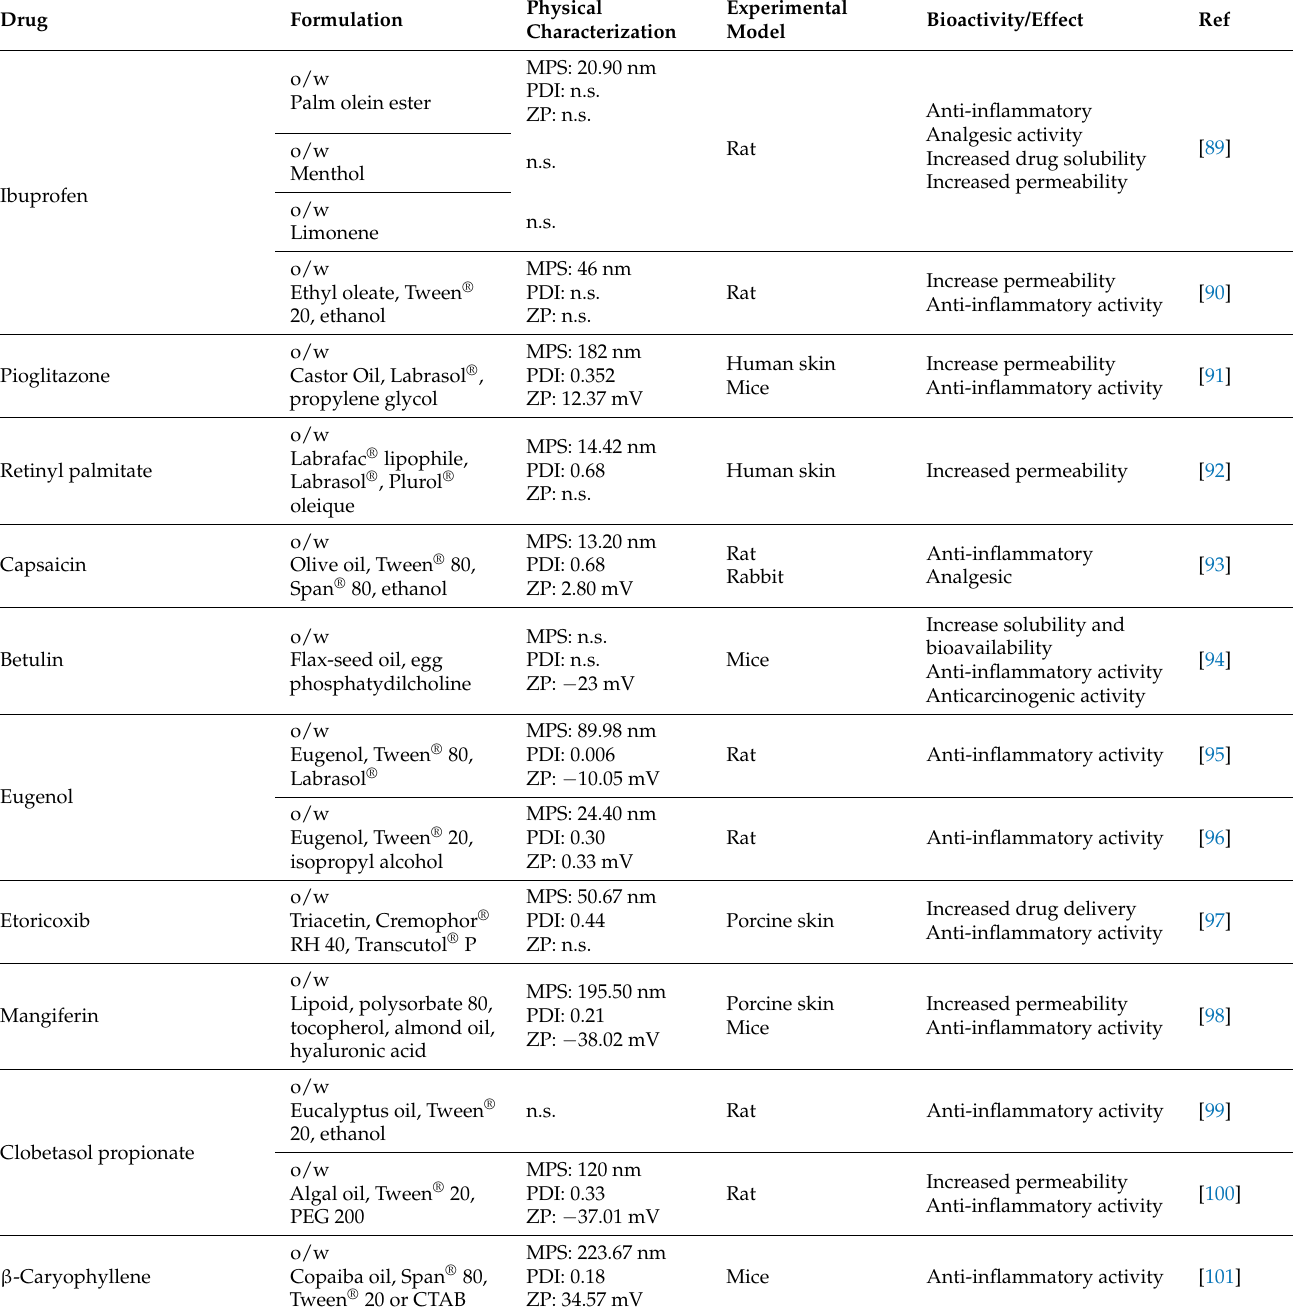
Table 1. Microemulsion and nanoemulsion technology applications to improve natural and synthetic drug delivery and